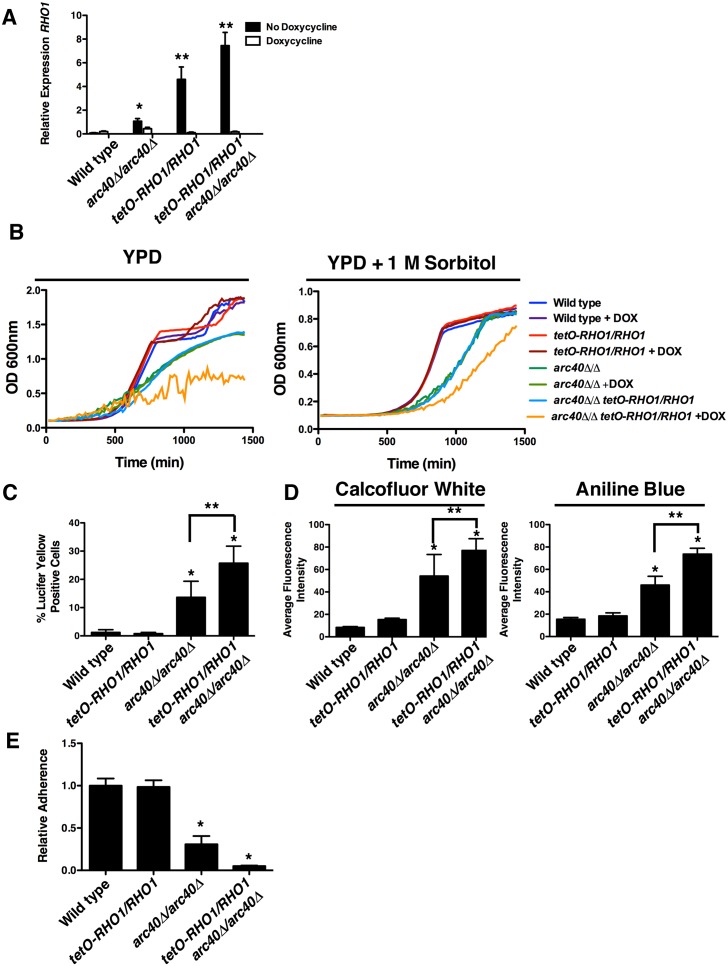
Loss of function of the Arp2/3 complex leads to hyperactivation of Rho1, altered cell wall physiology and impaired cell-to-surface adhesion.(A)
RHO1 transcript levels were monitored after strains were incubated for four hours in the presence and absence of doxycycline. The expression of RHO1 was normalized to a GPD1 control, and is plotted relative to the wild-type strain in the absence of doxycycline. Error bars represent standard deviation of technical triplicates. Experiment was performed in duplicate with a representative image shown. * indicates P<0.05, (ANOVA, Bonferroni's Multiple Comparison Test). ** indicates P<0.01. (B) Growth curves of strains cultured with or without doxycycline in YPD or YPD + 1M sorbitol. Growth was monitored by measuring optical density every 15 minutes. Experiment was performed in biological triplicate with representative plot shown. (C) Quantification of endocytosis defect by counting the number of cells staining positive for Lucifer Yellow, as described in Fig 6C. Error bars represent standard deviations of nine technical measurements. * represent significant adherence defects compared to a wild-type strain, and ** represents significant adherence defects between indicated strains (P<0.01, ANOVA, Bonferroni's Multiple Comparison Test). (D) Quantification of Calcofluor White and Aniline Blue fluorescence intensity to estimate the amount of chitin and glucan respectively in the fungal cell wall. Error bars represent standard deviation of five technical replicates. * represent significant adherence defects compared to a wild-type strain, and ** represents significant adherence defects between indicated strains (P<0.01, ANOVA, Bonferroni's Multiple Comparison Test). (E) Adherence was evaluated and measured as described in Fig 1C. Error bars represent standard deviations of five technical replicates. Asterisks represent significant adherence defects compared to a wild type strain (P<0.001, ANOVA, Bonferroni's Multiple Comparison Test).